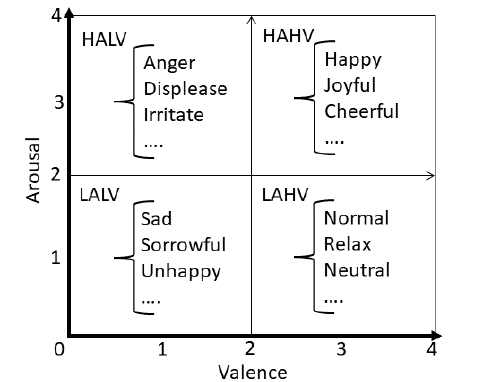
Figure 1. Emotion distribution and classes distribution based on the Russell circumplex model. This structure allowed us to carry out a multiclass classification